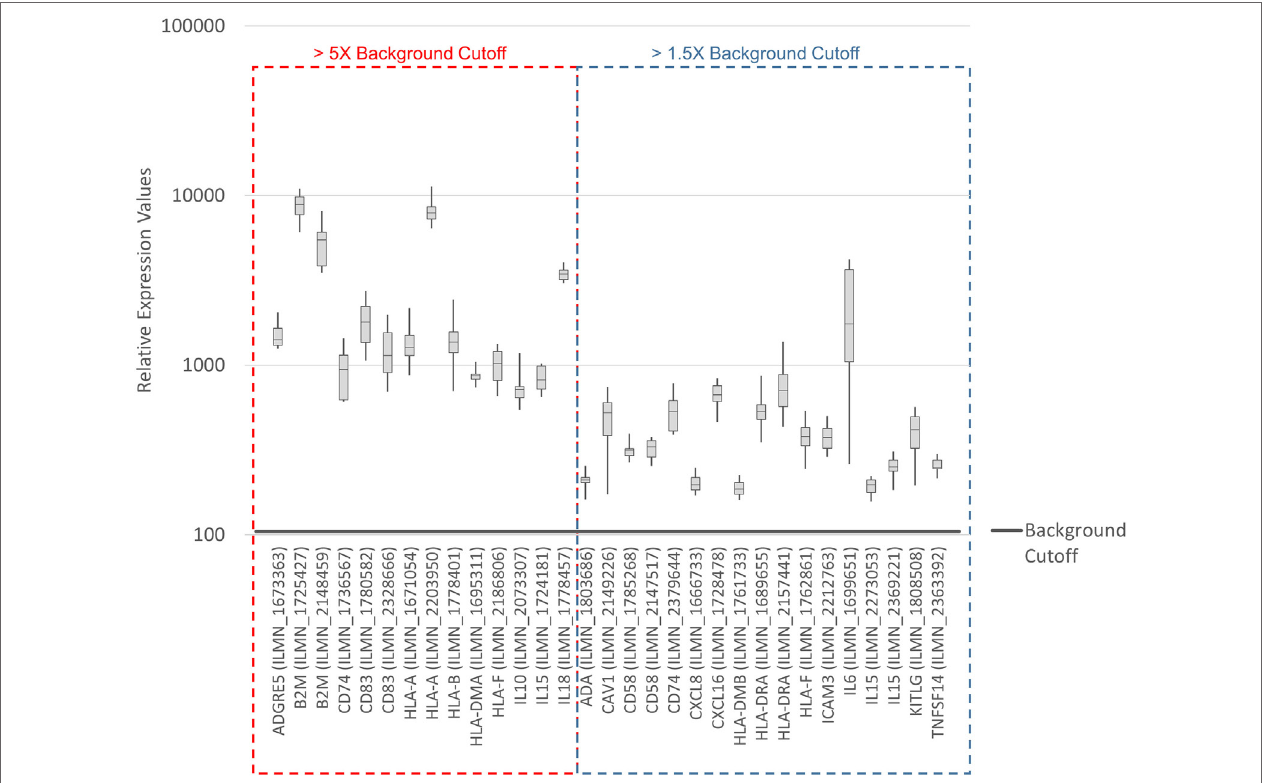
FigUre 2 | Microarray-based transcript levels of immunostimulatory factors expressed in SV-BR-1-GM cells. 111 genes with known immunostimulatory roles were identified in published reports (41–83) (Data Sheet S3 in Supplementary Material) and their microarray-based RNA expression levels determined. The 22 genes shown presented with transcript levels > 1.5 times the background cutoff value (median quantile-normalized “expression” level, see Materials and Methods) in each of the SV-BR-1-GM samples. “Relative Expression Values” refers to quantile-normalized mRNA levels. ILMN_... refer to the Illumina probe sequence identifiers (PROBE_ID) of the probes yielding the expression levels